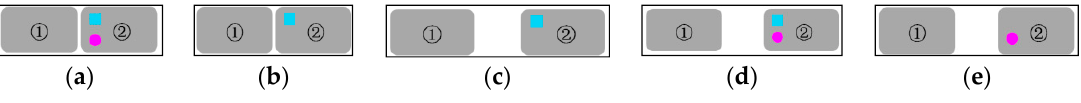
Figure 6. Explanation of different hire modes. The grey block stands for a horizontal bar in the revised Gantt chart, and two optional glyphs (blue square and purple circle) are added on the bar if necessary to indicate different user hire patterns. ( a ) Mode A; ( b ) Mode B; ( c ) Mode C; ( d ) Mode D; ( e ) Mode E.